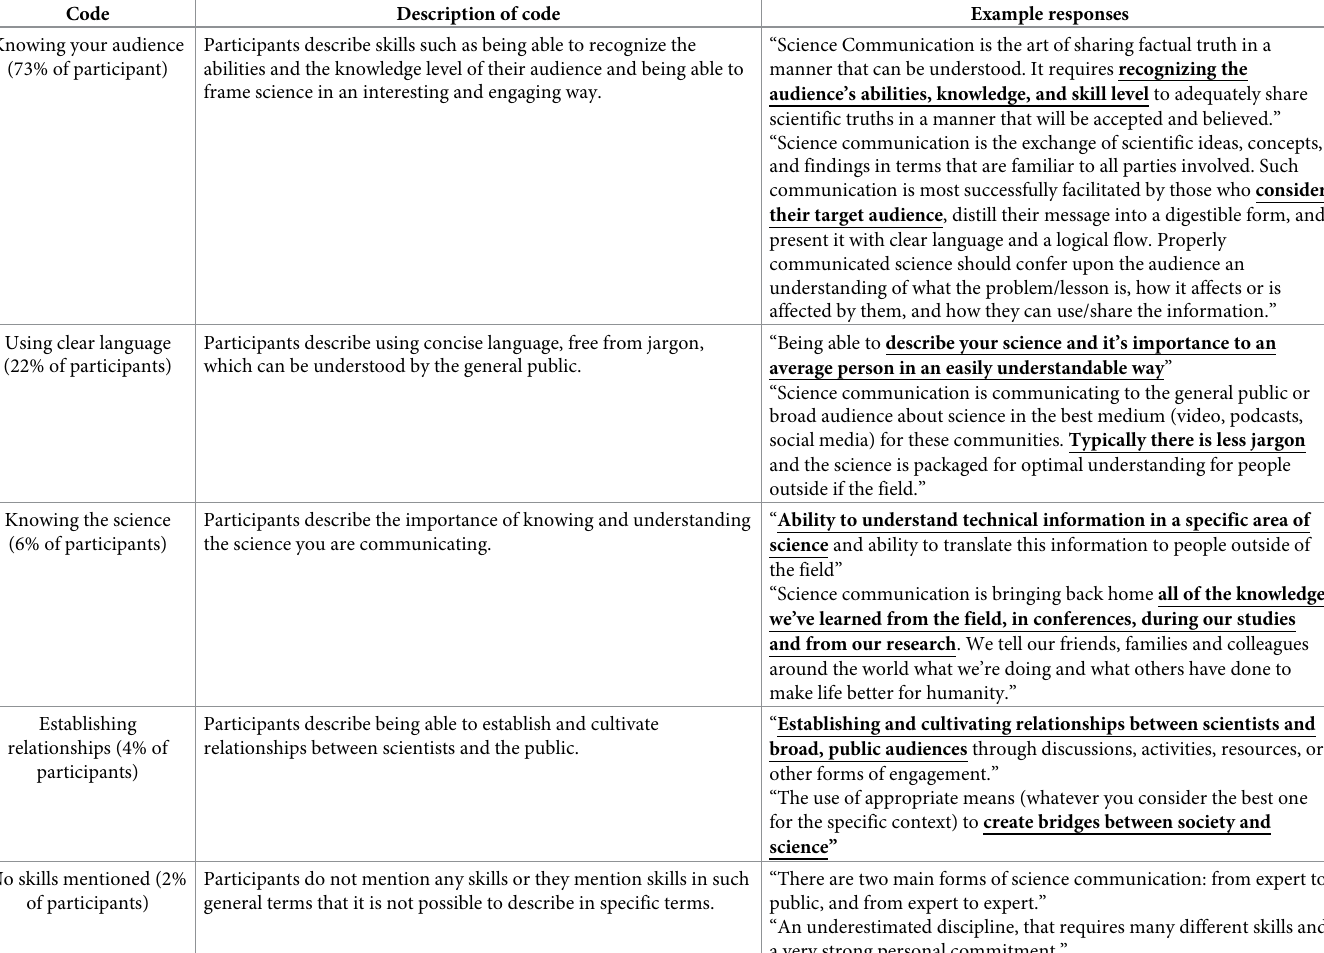
Table 1. Skills STEM graduate students report being needed to communicate